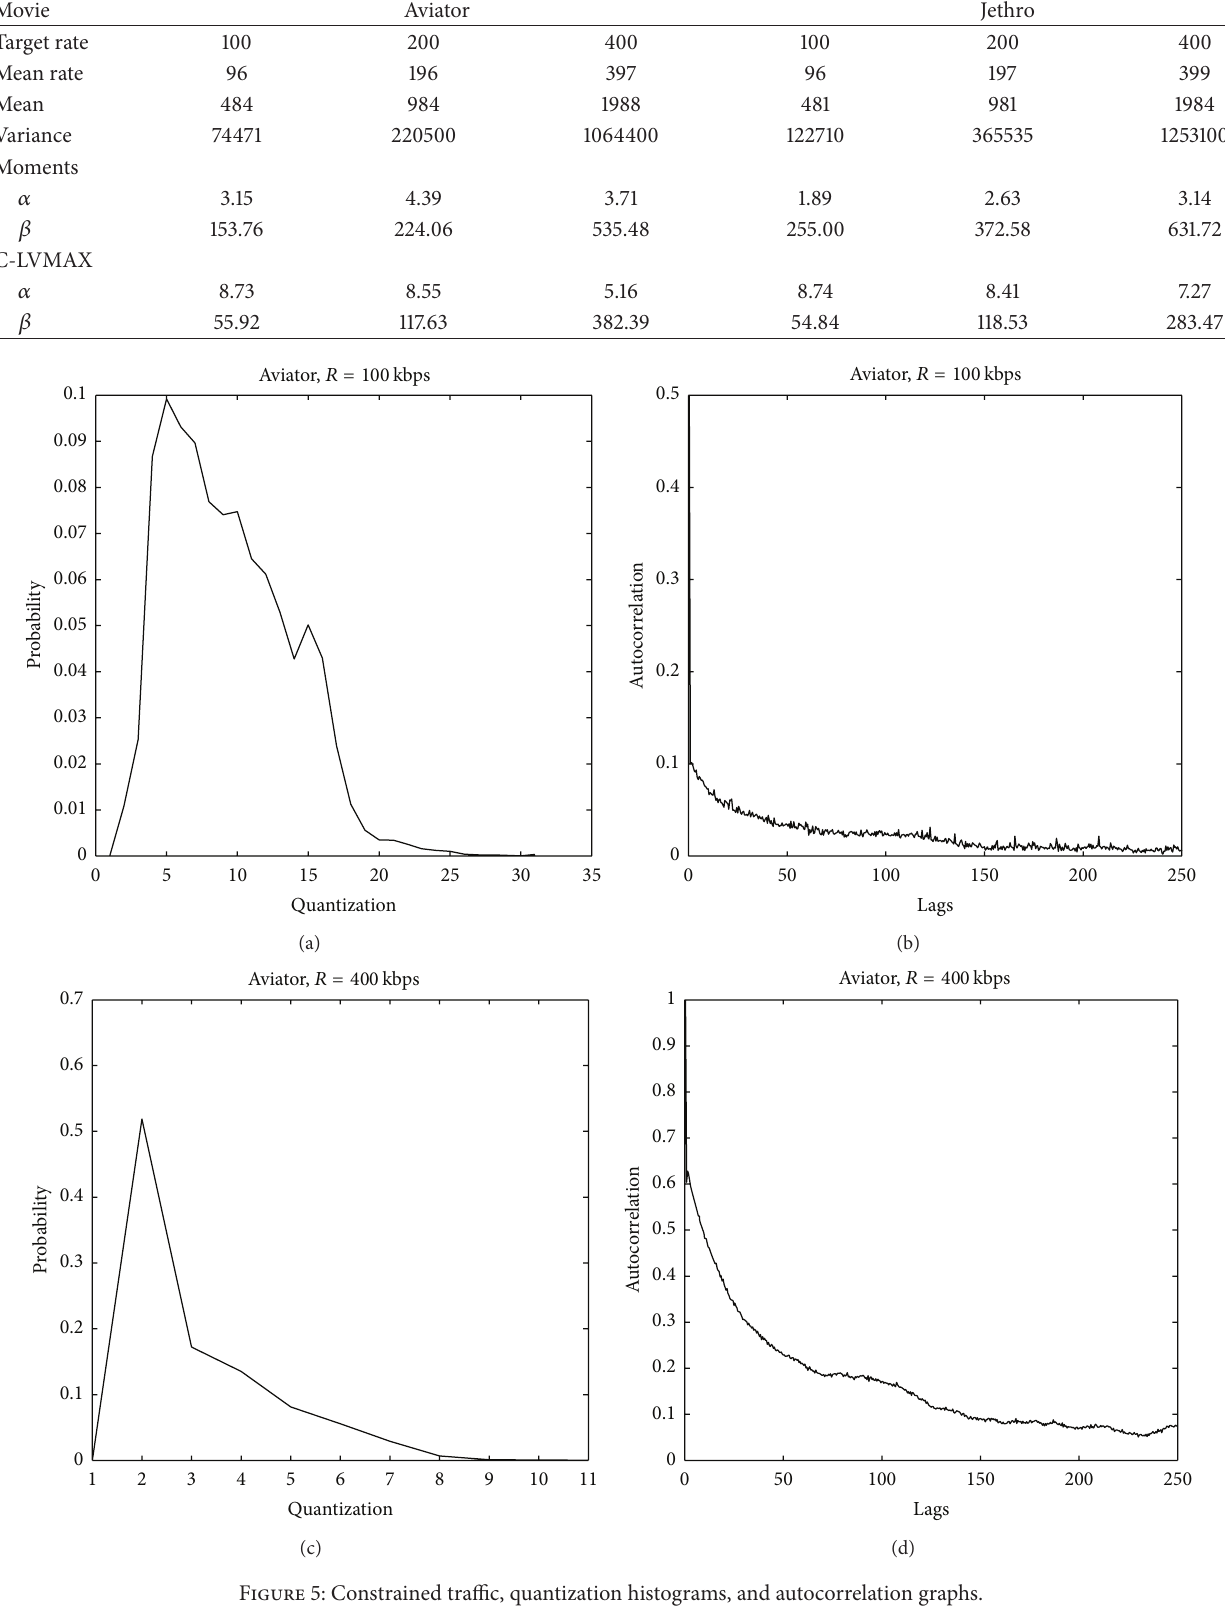
Table 2: Statistics for Aviator (22min) and Jethro Tull (30,55 min) in rate control mode.